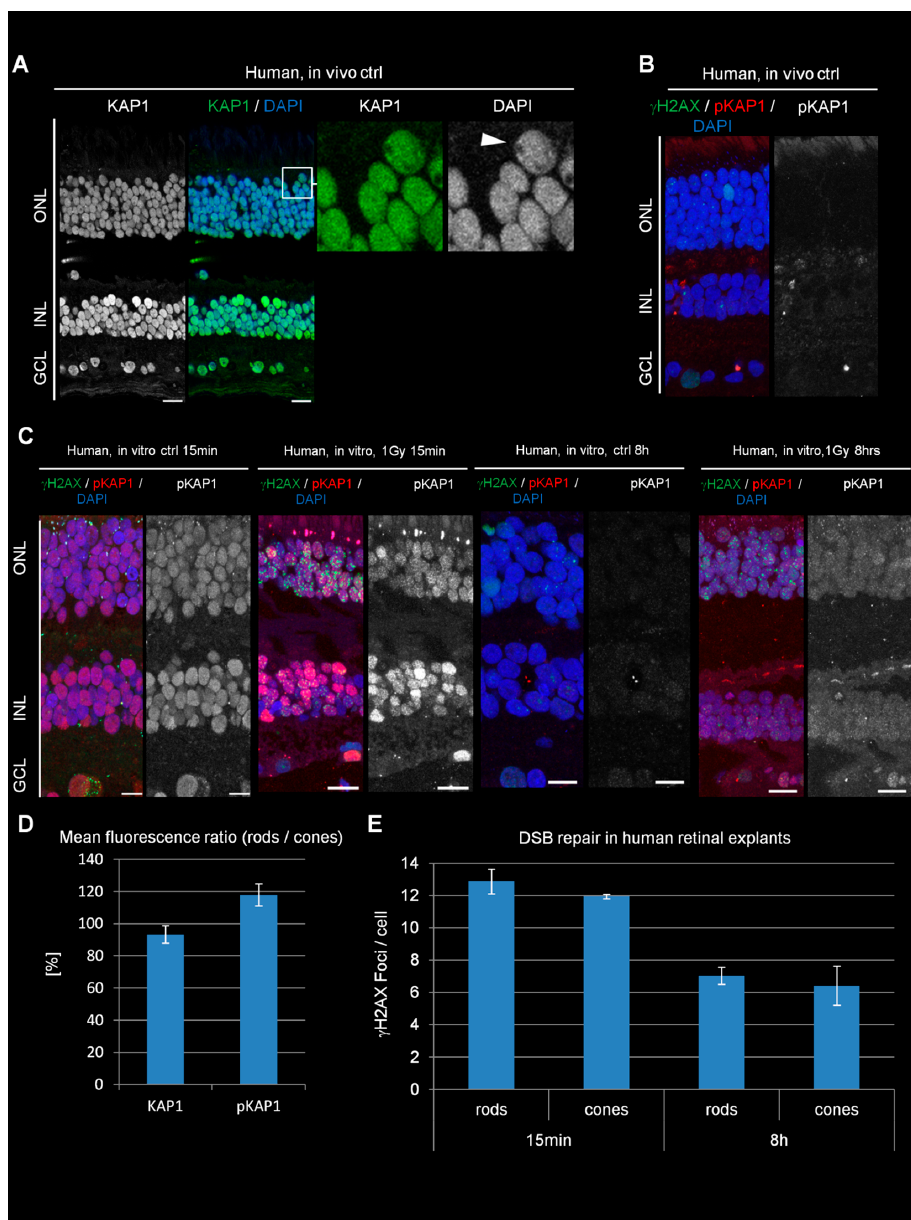
Figure 4. KAP1 expression and its radiation-induced phosphorylation in human retinal explants. ( A ) Immunofluorescence images of KAP1 (green) in human retinal explants. Nuclei were counterstained with DAPI (blue). Scale bars represent 10 μ m. ( B ) Immunofluorescence images of spontaneous γ H2AX foci (green) and pKAP1 (red) in directly fixed retina (in vivo ctrl). ( C ) Immunofluorescence images of γ H2AX foci (green) and pKAP1 (red) in in vitro ctrl and irradiated human retinal explants at 15 min and 8 h after 1 Gy. Nuclei were counterstained with DAPI (blue). Scale bars represent 10 μ m. ( D ) Quantification of the KAP1 and pKAP1 signals in the nuclei of rods compared to cones. The pKAP1 ratio was measured at 15 min after 1 Gy. ( E ) Quantification of IR-induced γ H2AX foci in rods and cones of retinal explants at 15 min and 8 h after 1 Gy. Data are presented as mean ± SEM from the analysis of three retinal explants for each time point ( n = 3). Control values are subtracted. p -values were obtained by t test and represent a comparison of all cells analyzed in the indicated cell population (at least 10 cells per data point and experiment for foci quantification and 10 nuclei for KAP1/pKAP1 fluorescence measurements in rods and cones). ONL = outer nuclear layer, INL = inner nuclear layer, GCL = ganglion cell layer.